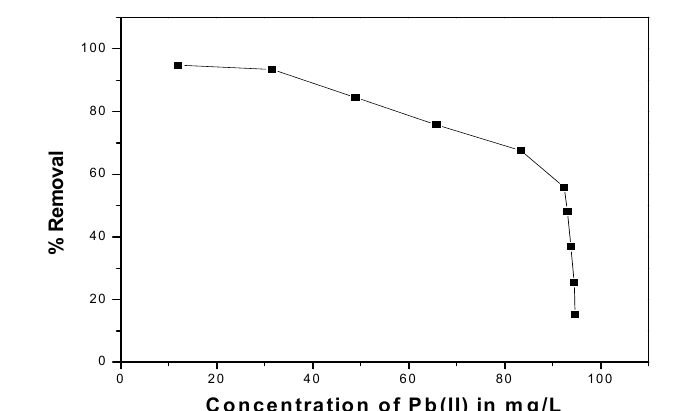
Fig.10. Effect of initial concentration of Pb(II)